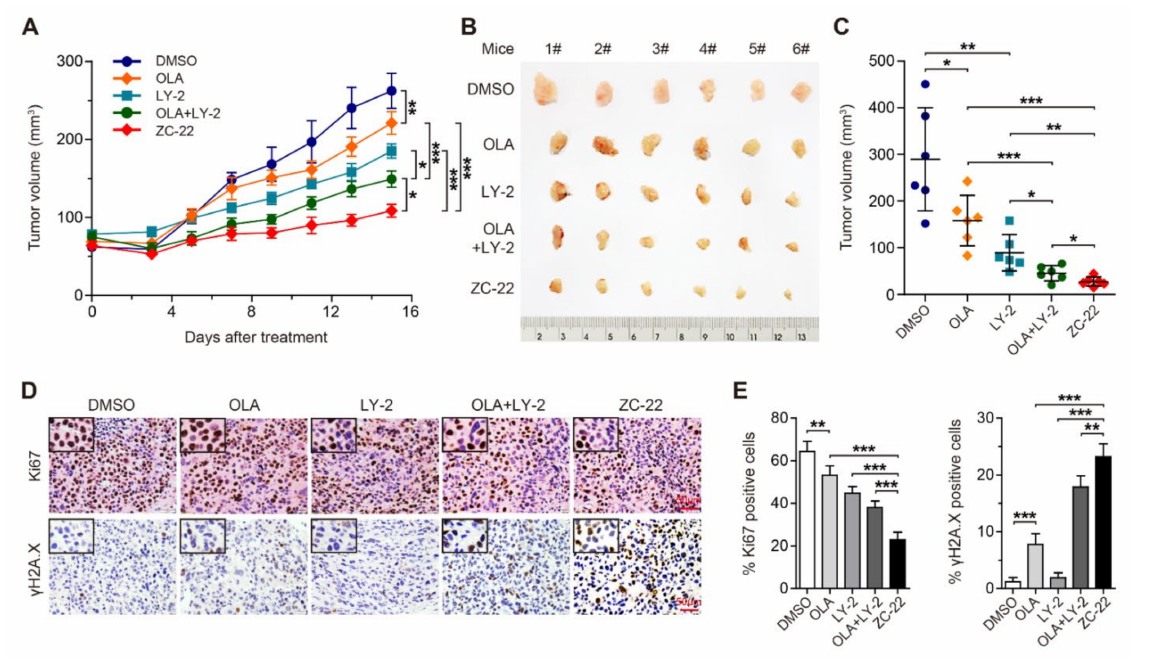
Figure 4. ZC-22 suppresses growth of breast cancer xenografts. Female NOD-SCID mice were injected subcutaneously with 2 × 10 6 of MDA-MB-231 cells and treated ip daily with 50 mg/kg of Olaparib (OLA) or LY2835219 (LY-2) alone or together (OLA + LY-2) or with ZC-22 alone starting on day 10 after injection of cells when tumors were 50–80 mm 3 in size. Tumor volumes were measured every 2–3 days. ( A ) Growth curve of the MDA-MB-231 xenograft tumors with indicated treatment. Values are means ± SEM, n = 6. ( B , C ) Pictures of ( B ) and quantification of the size of ( C ) the MDA-MB-231 xenograft tumors at the end points. Values are means ± SD, n = 6. ( D ) Immunohistochemical staining of Ki67 (top panels) and γ H2A.X (bottom panels) in the MDA-MB-231 xenograft tumor tissues. ( E ) Quantification of Ki67 (Left) and γ H2A.X (Right)-positive cells in immunohistochemical staining of the xenograft tumor tissues. Values are means ± SEM, n = 6. * p < 0.05, ** p < 0.01, and *** p < 0.001 in an unpaired t